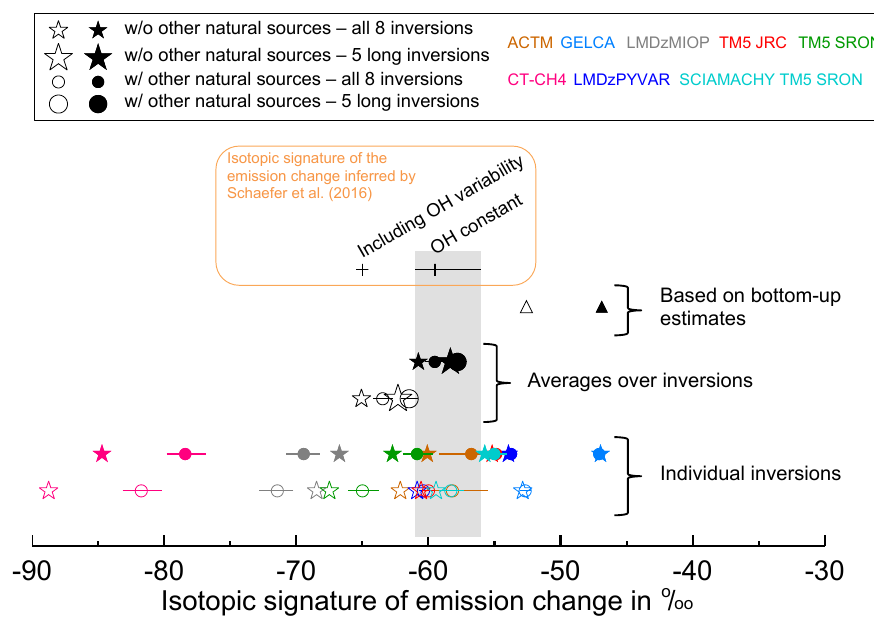
Figure 6. Isotopic signature (in ‰) of the emission change between 2002–2006 and 2008–2012 based on Eq. (1) and the isotopic source signatures from Schaefer et al. (2016) and Schwietzke et al. (2016) in filled and open symbols, respectively. The range of the isotopic signature of the emission change derived by the box model of Schaefer et al. (2016) is indicated as the grey shaded area when assuming constant OH. The isotopic signatures derived from the ensemble of bottom-up estimates are shown with a triangle symbol. The individual inversions are shown in colour. The mean inversion estimates are shown with circles and stars, taking and without taking into account the “other natural” sources, respectively. The range around the circle indicates the range due to the choice of the isotopic source signature for the “other natural” source between − 40 and − 57‰ (see